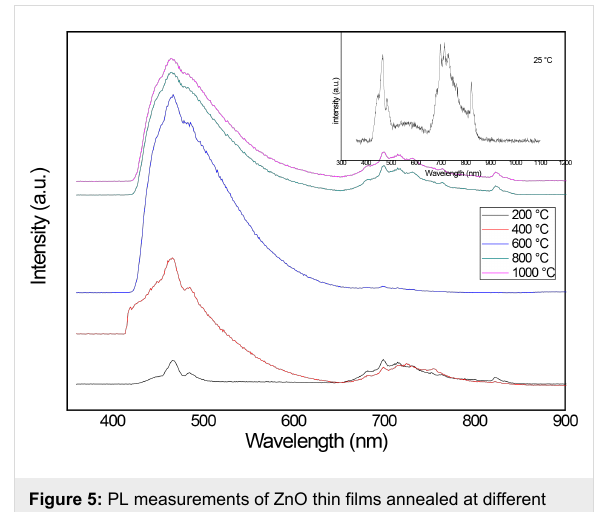
Figure 5: PL measurements of ZnO thin films annealed at different